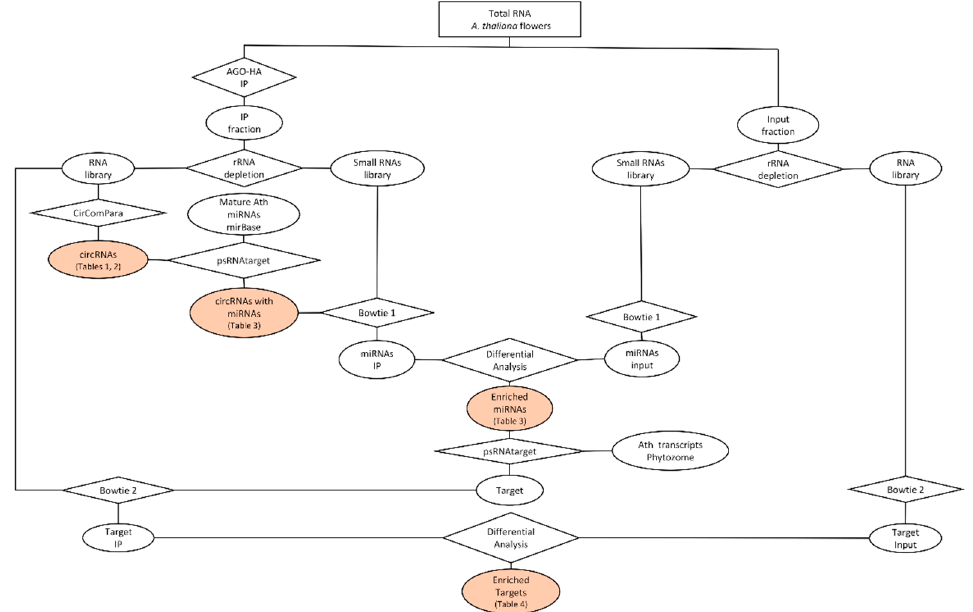
Figure 1. Flowchart for identification of circRNAs, miRNAs and target mRNAs in AGO-IP and control libraries. The total RNA from A. thaliana flowers was divided in two fractions. One of them went through Argonaute immunoprecipitation (IP fraction) and the other was used as control (Input fraction). Different methodologies are represented by rhombus, while the outputs are represented by ellipses. Filled ellipses correspond to results also presented in tables.